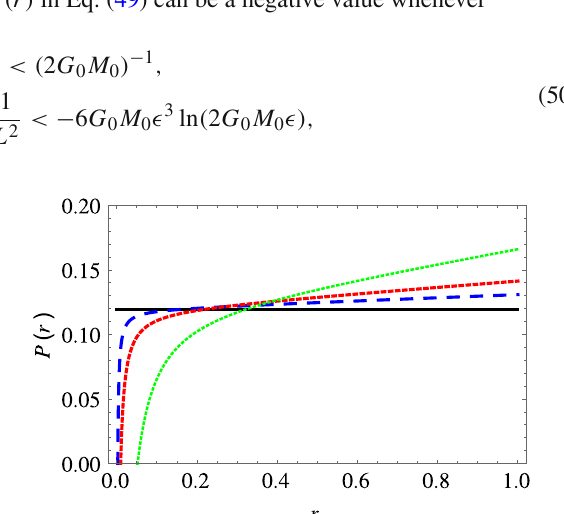
Fig. 2 Polytropic pressure function for (cid:13) = 0 . 00 (black solid line), (cid:13) = 0 . 05 (dashed blue line), (cid:13) = 0 . 10 (short dashed red line), (cid:13) = 0 . 25 (dotted green line). The other values have been taken as unity